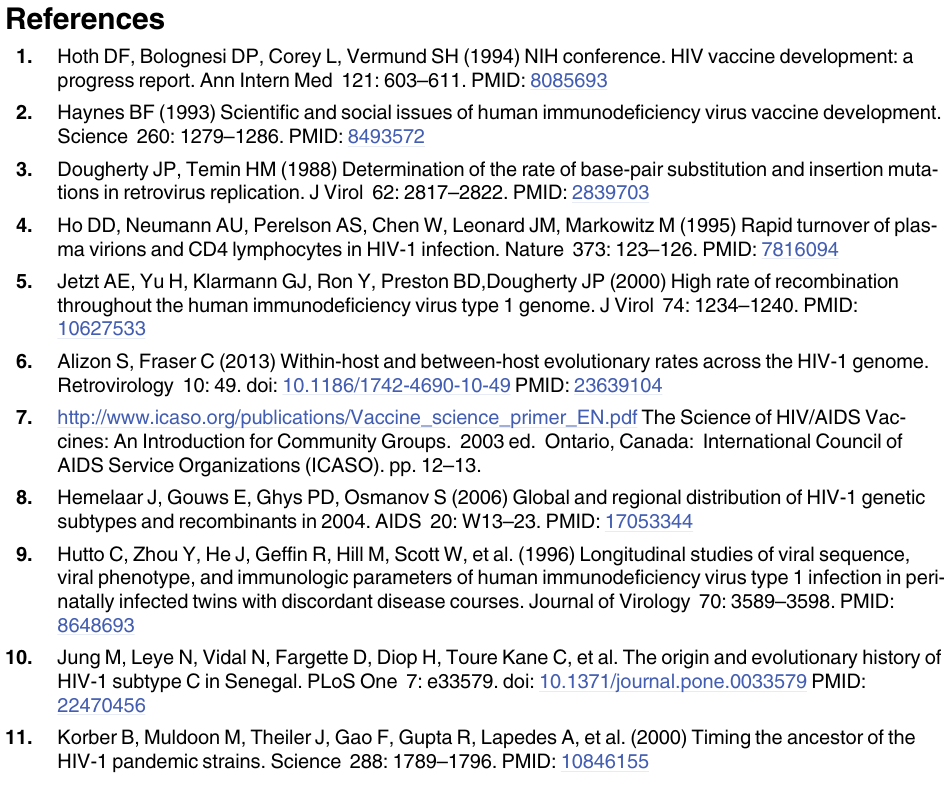
S1 Fig. Phylogenetic trees of HIV-1 Tat. Figure A) Maximum likelihood (ML), and Figure B) Neighbor-joining phylogenetic tree of HIV-1 subtypes B and C sequences based on 300 nucleo- tide sites of Tat gene sequences generated through the Los Alamos database. GTR+I+ Γ 5nucle- otide substitution model was employed with 1000 bootstrapped data sets using MEGA 6. The HIV-1 Subtypes B and C Tat sequences are shown in green and pink round bullets, respective- ly. SIV sequence, CPZ.US.85.US_Marilyn.AF103 was used as the out-group to root the tree (red square bullet). S1 Table. Accession numbers of the different subtypes of HIV-1 Tat used in this study ob- tained from the Los Alamos National Laboratory (LANL) HIV